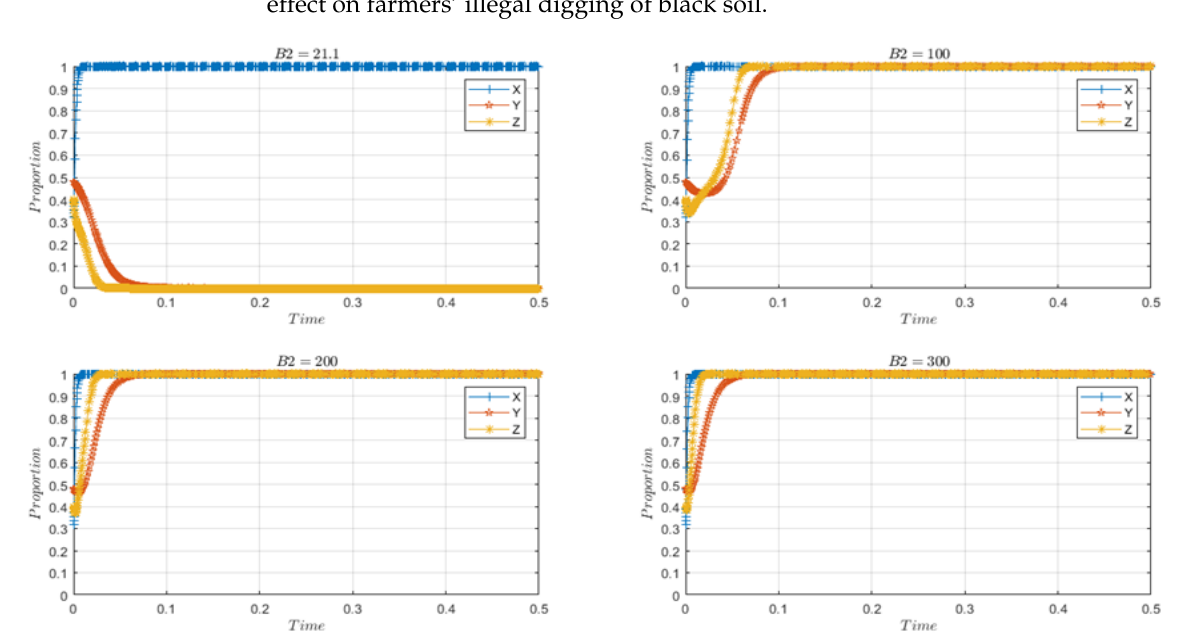
Figure 6. The evolution path under different farmers’ fines: ( a ) evolution path of System A with (x 0 , y 0 , z 0 ) = (0.32, 0.48, 0.4); ( b ) evolution path of System B with (x 1 , y 1 , z 1 ) = (0.7, 0.7, 0.7). effect on farmers’ illegal digging of black soil.